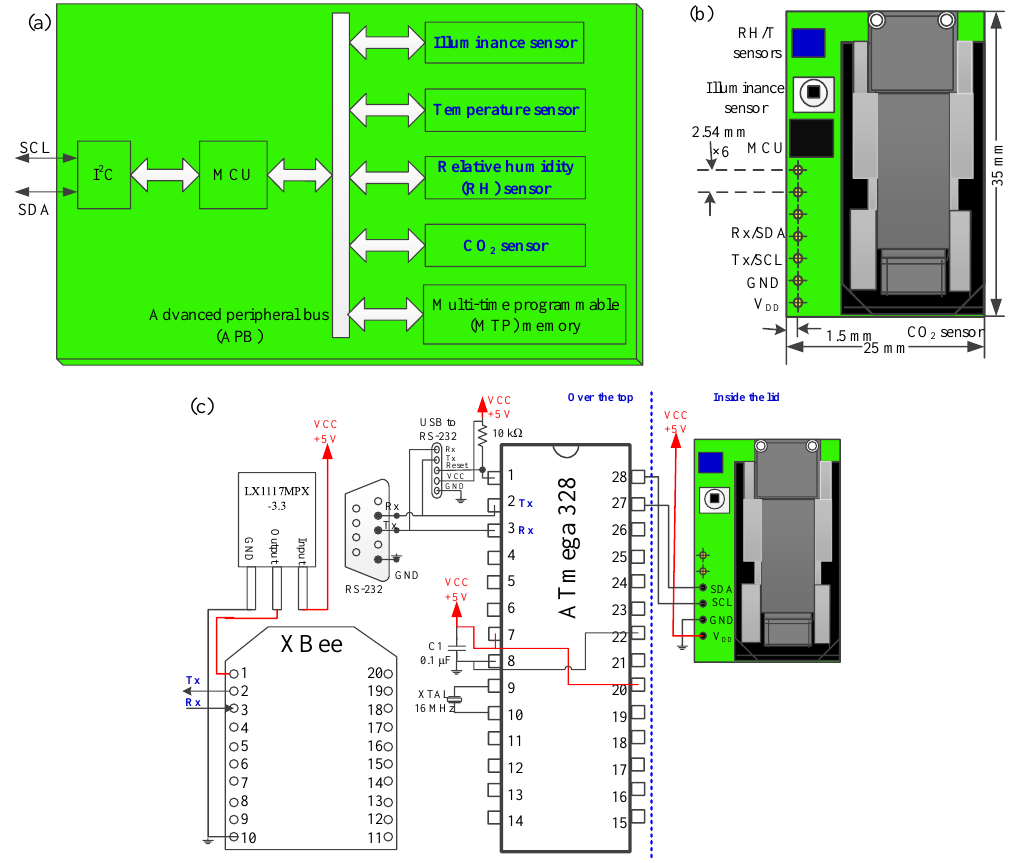
Figure 2. Schematic of wireless multisensor module. ( a ) Function block; ( b ) sensor layout arrangement; ( c ) wireless configuration.